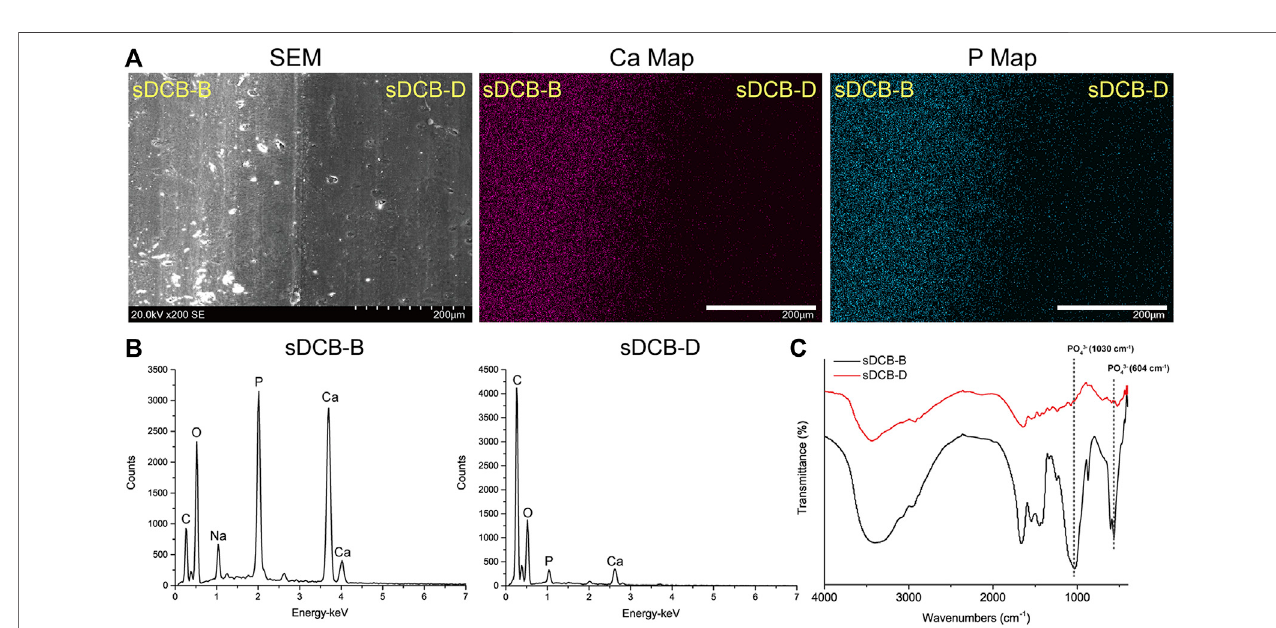
FIGURE 2 | Characterization of the sDCB. (A) SEM image and EDX mapping of Ca and P elements in sDCB. Scale bar (cid:1) 200 μ m. (B) EDX analysis in two different regions of sDCB. (C) FT-IR spectra of two different regions of sDCB.